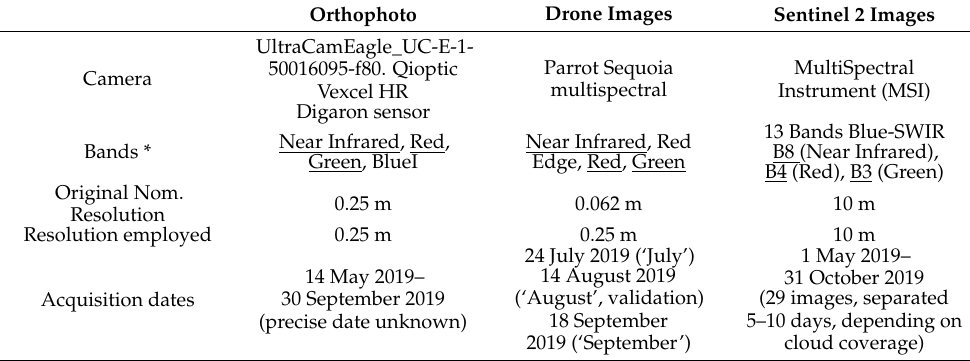
Table 2. Summary of main technical specifications of images and bands used in this work. Orthophoto Drone